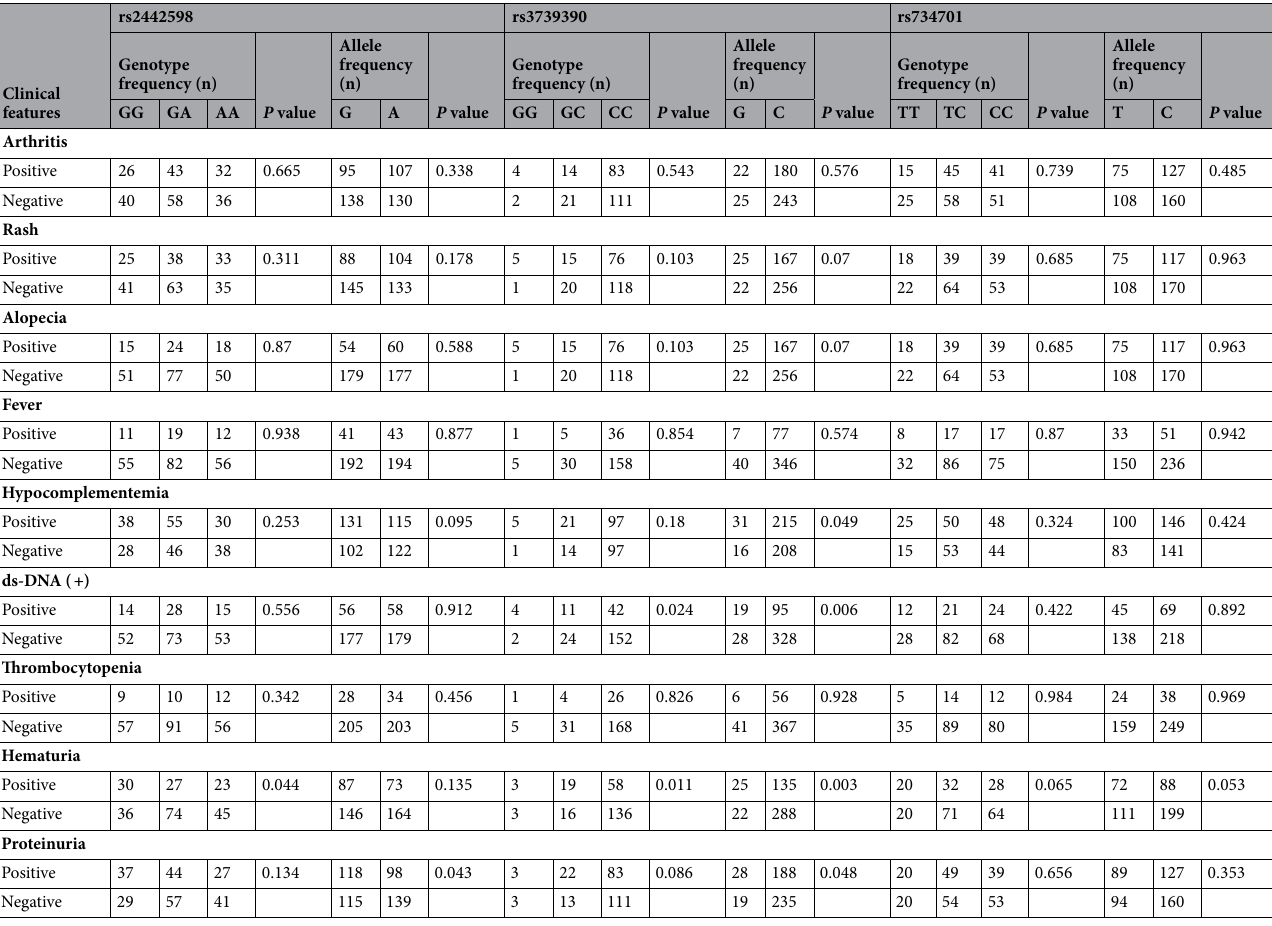
Table 5. Association between clinical, laboratory features and allele and frequencies of rs2442598, rs3739390, rs734701 SNPs of Ang2 gene in SLE. SLE, systemic lupus